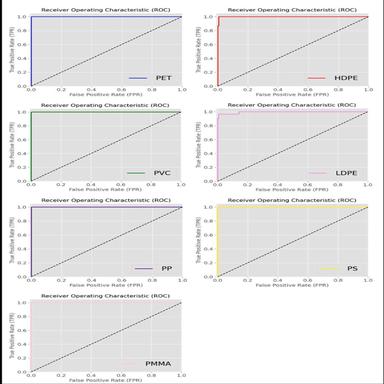
The receiver operating characteristic (ROC) curve for prediction of plastic classes based on Raman spectra using PLS-SVM model.